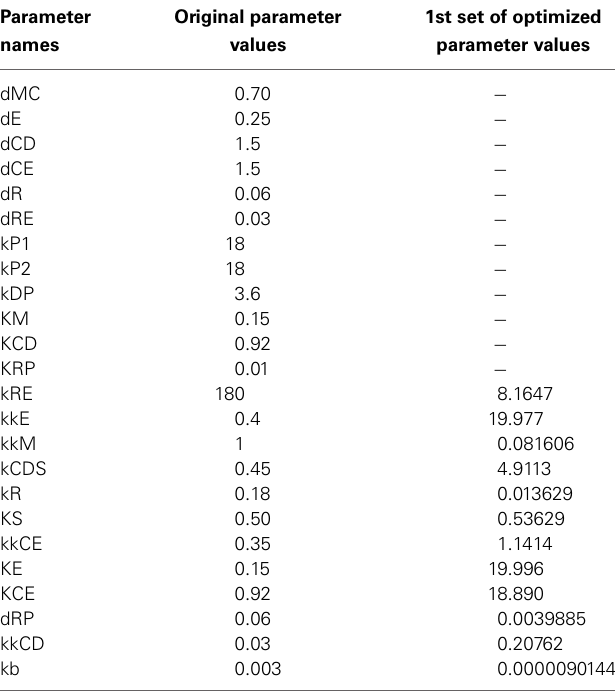
Table 1 | The original and 1st sets after parameter optimization.